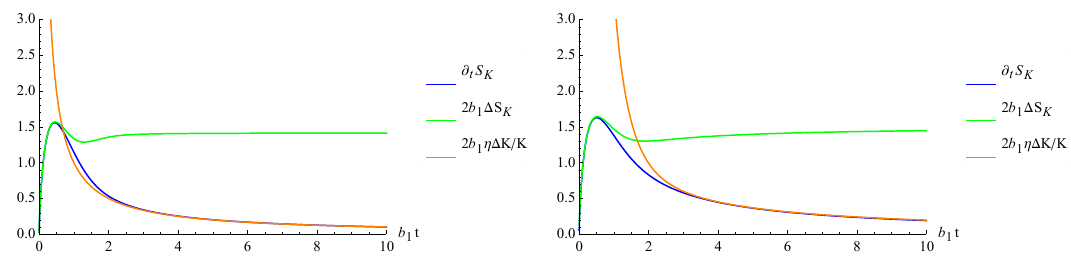
Figure 3 . Entropy growth for integrable model b n = αn δ . Left panel: the Heisenberg-Weyl case δ = 1 / 2 . The bound ∂ beyond the critical time scale t from below and the relation (4.20) can be extended to finite times t ≥ t